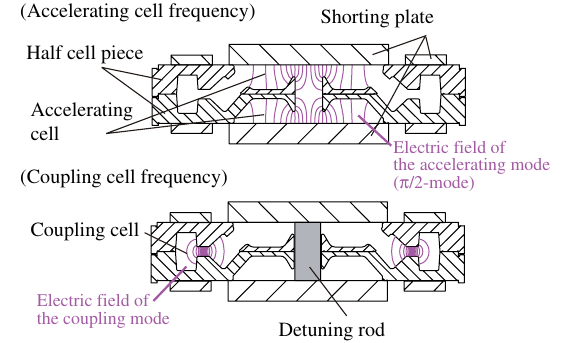
FIG. 5. Measurement setup and electric-field distribution for the normal cell frequencies. The frequencies were measured by a pair of two half-cell pieces using shorting plates. The accelerating-cell frequency was measured for the (cid:1)= 2 mode. The coupling-cell frequency was evaluated from the detuning measurement by using a detuning rod placed at the beam axis. The field distributions were calculated by using SUPERFISH for the axially symmetric cells (without the coupling